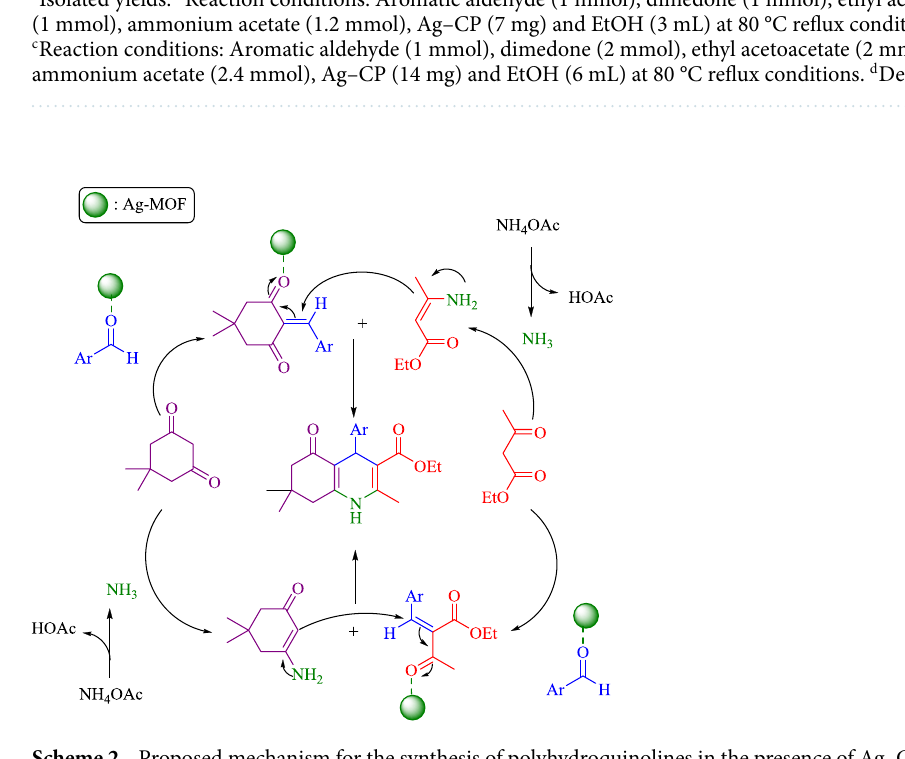
Scheme 2. Proposed mechanism for the synthesis of polyhydroquinolines in the presence of